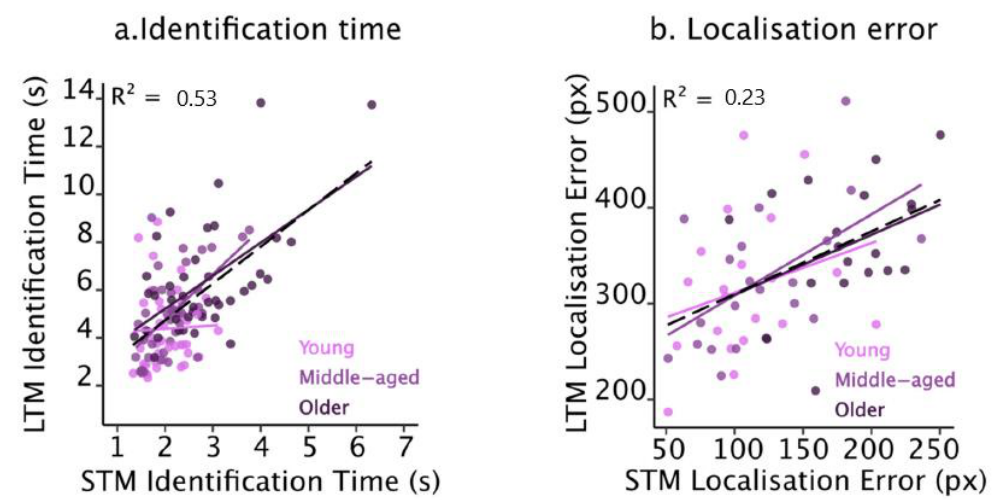
Figure 3. The relationship between STM and LTM for Identification times ( a ) and localisation errors ( b ) across age groups for the three object trials in Experiment 1. Coloured dots represent participant means, and coloured lines represent regression lines per age group. Dashed black lines represent model fit across groups. Regression coefficients are reported for the most parsimonious models only, which was LTM~STM in both